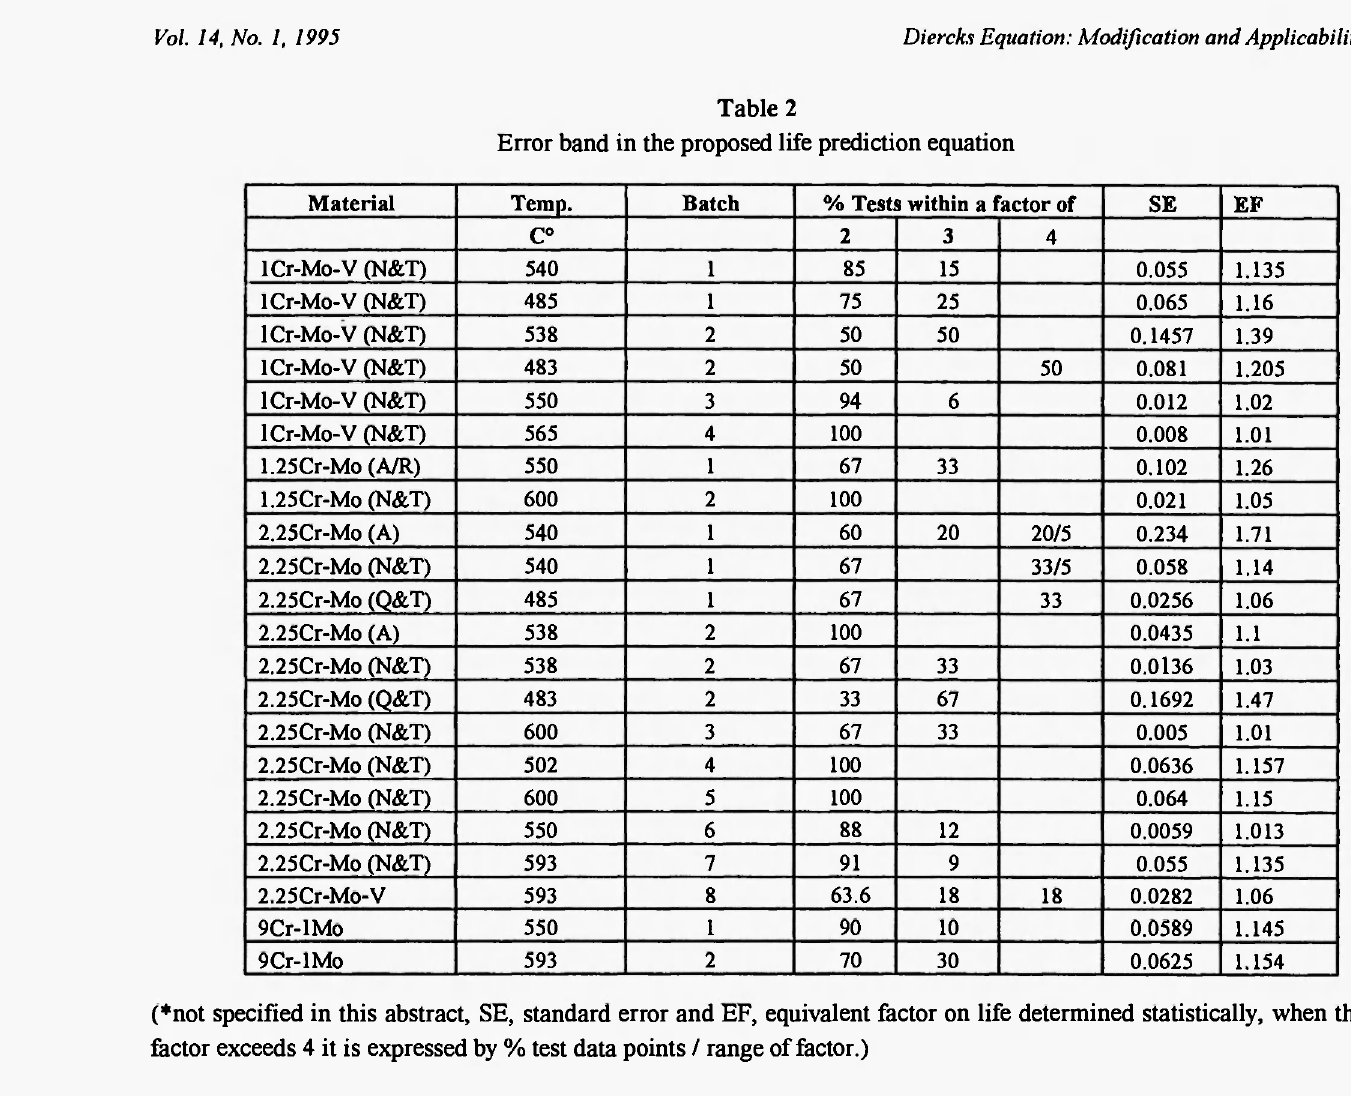
Error band in the proposed life prediction equation Material